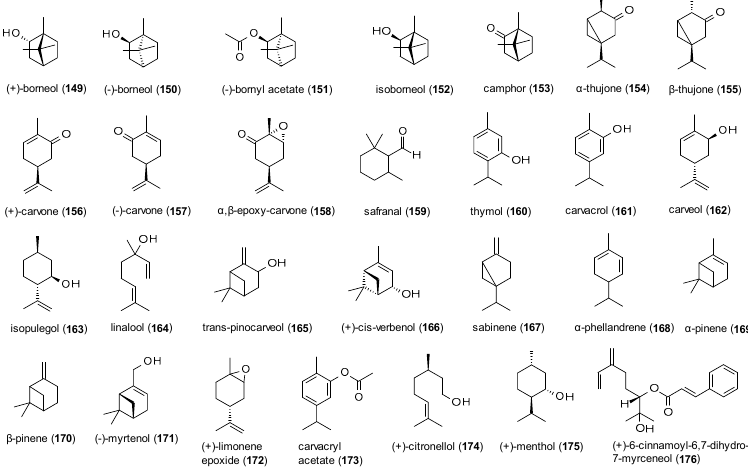
Figure 11. Chemical structures of monoterpenes with reported GABA(A)-receptor modulating activity. Granger et